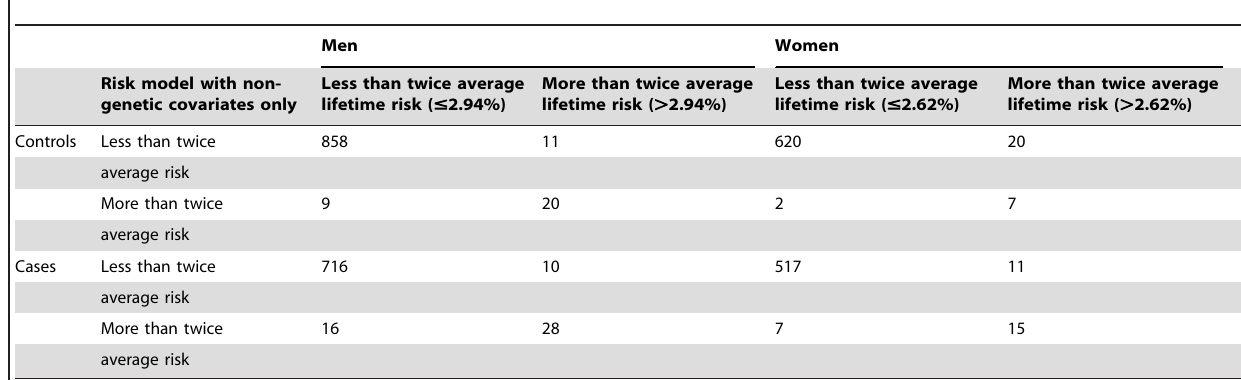
Table 3. Reclassification of lifetime risk of pancreatic cancer after adding genetic information to the risk model with both genetic and non-genetic